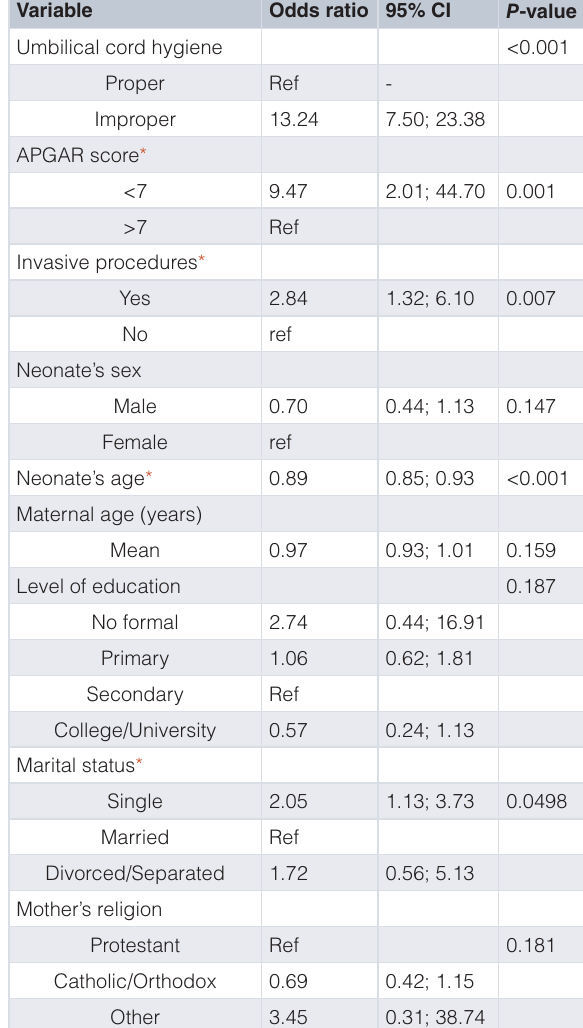
Table 4. Association between umbilical cord hygiene, neonatal and maternal factors with neonatal sepsis among neonates attending KHC, Kenya,